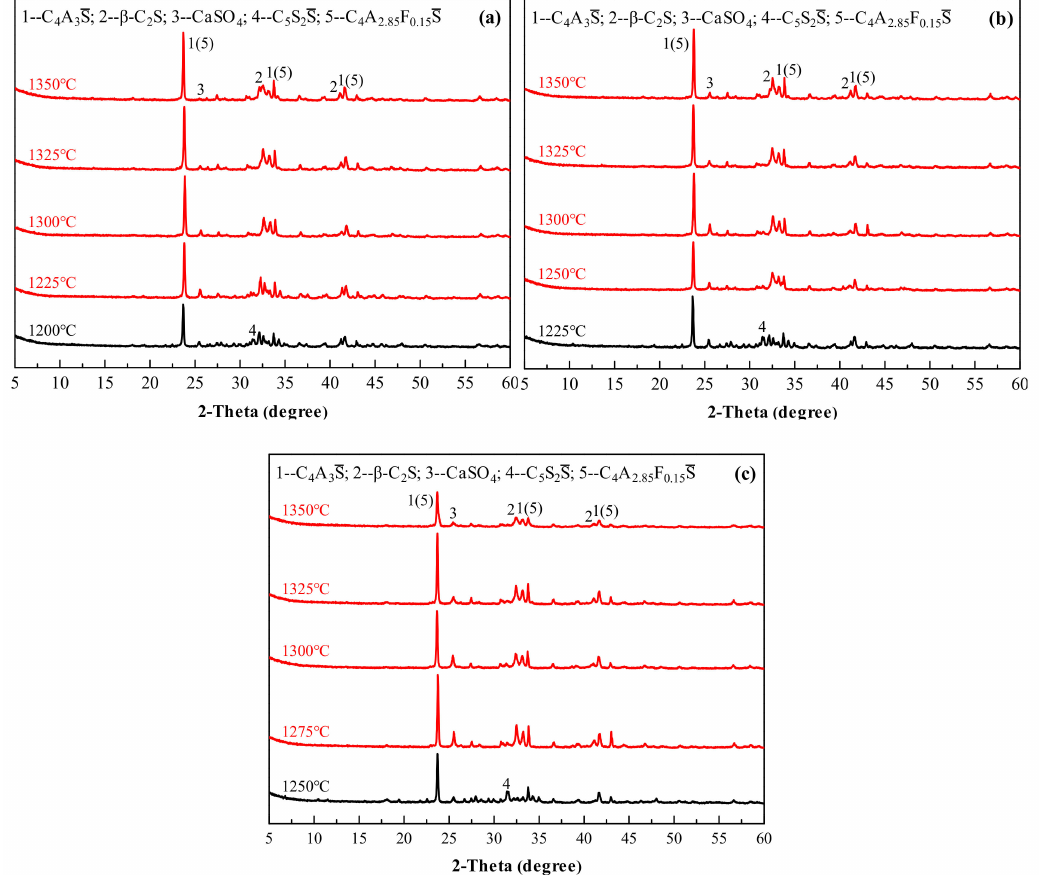
Figure 8. X-ray di ff raction (XRD) patterns of the Series GF-HBSAC-Y cement clinkers at di ff erent temperatures: ( a ) GF-HBSAC-10%; ( b ) GF-HBSAC-15%; ( c ) GF-HBSAC-20%.